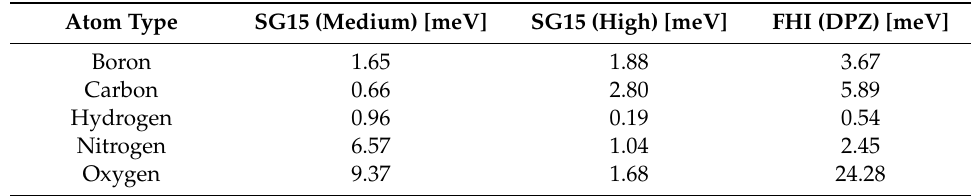
Table 1. Comparison of delta-test results for pseudopotentials and basis set with chosen atoms that were used in the investigated